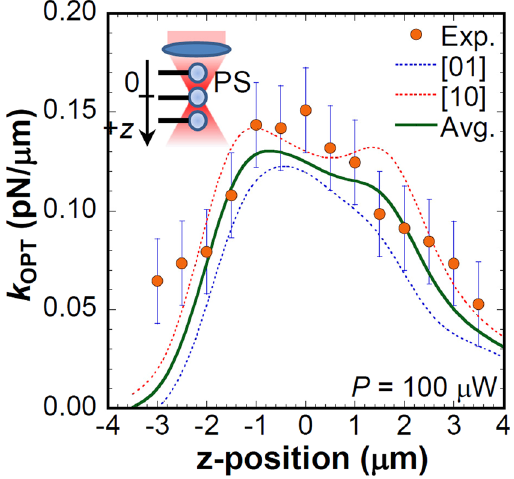
Figure 5. z -position dependence of k OPT . Experimental results were obtained by changing the focal position along the z-axis as presented schematically in the inset under irradiation of 100 μ W. Theoretical curves for the z -position dependence of k OPT ,x are also shown. The error bar shows the standard deviation obtained from five